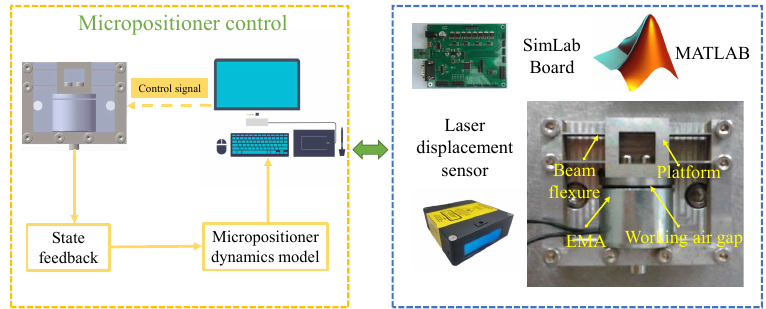
Figure 12. The schematic diagram of experiment system.